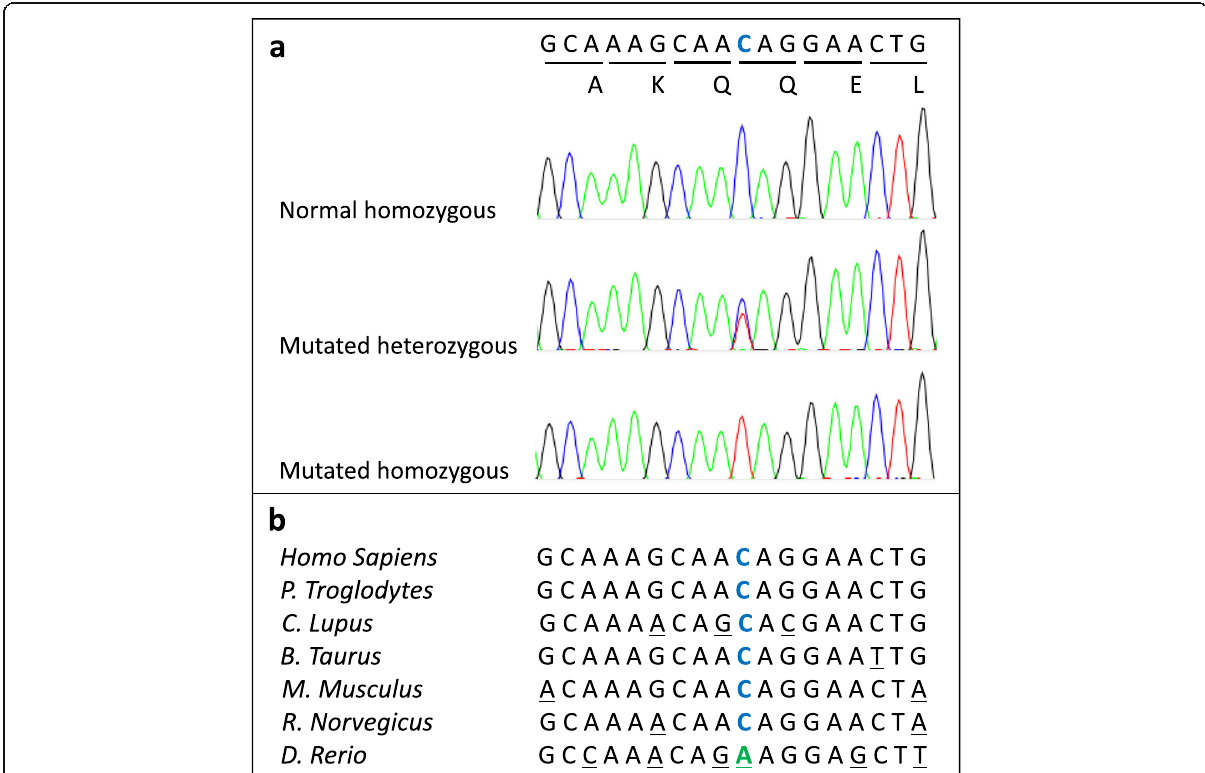
Fig. 3 Sanger validation and conservation of the novel discovered VPS13A nonsense mutation. a Sanger sequencing confirms the presence of the Gln113* mutation in VPS13A at heterozygous and homozygous state; b Partial amino acid sequence alignment of human VPS13A with orthologs shows evolutionary conservation between species of the Glutamine